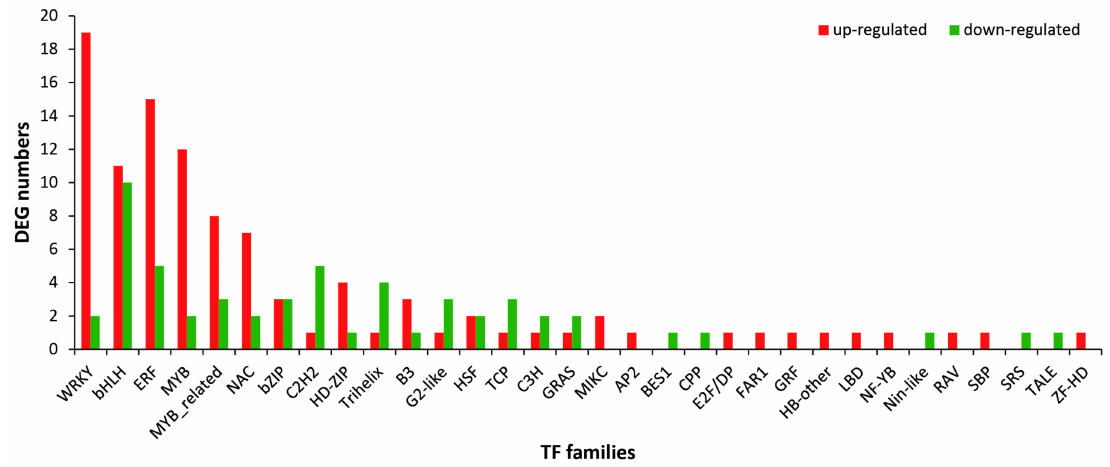
Figure 5. Statistics of differentially expressed TFs under MeJA